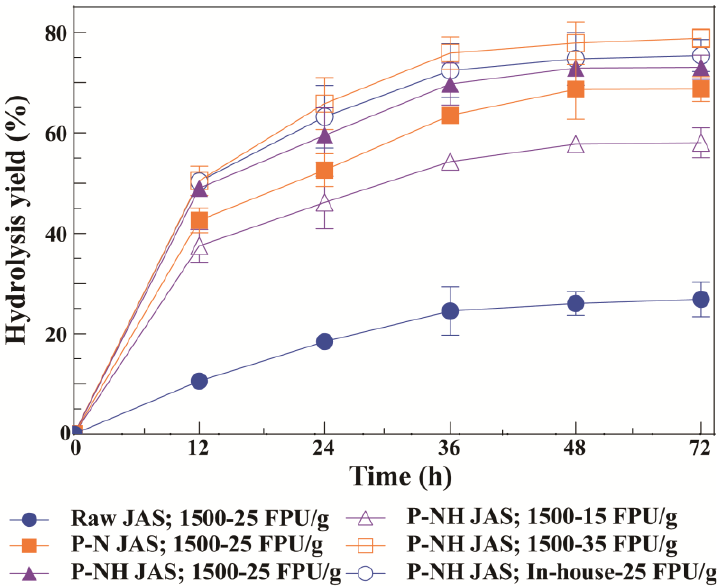
Figure 2. Enzymatic hydrolysis (5% substrate concentration, w / v ; 50 ◦ C; pH 4.8) of raw and pretreated Jerusalem artichoke stalk (JAS) using two enzyme combinations. P-N JAS: NaOH-pretreated JAS, P-NH JAS: CO-pretreated JAS; 1500: Accellerase ® 1500, 1110: in-house cellulase.